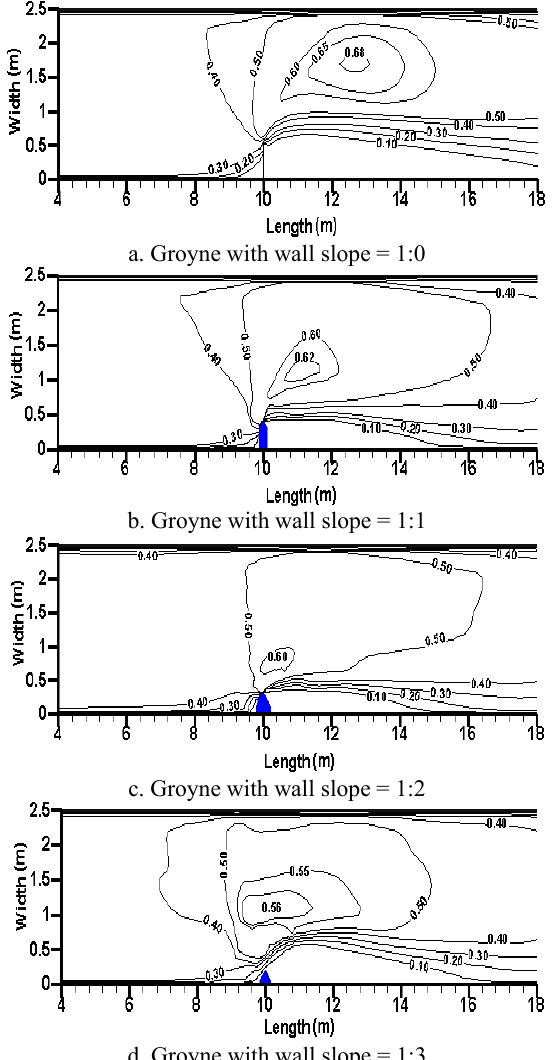
Fig.10 Isolines of velocities at z=+0.2m for the flat bed